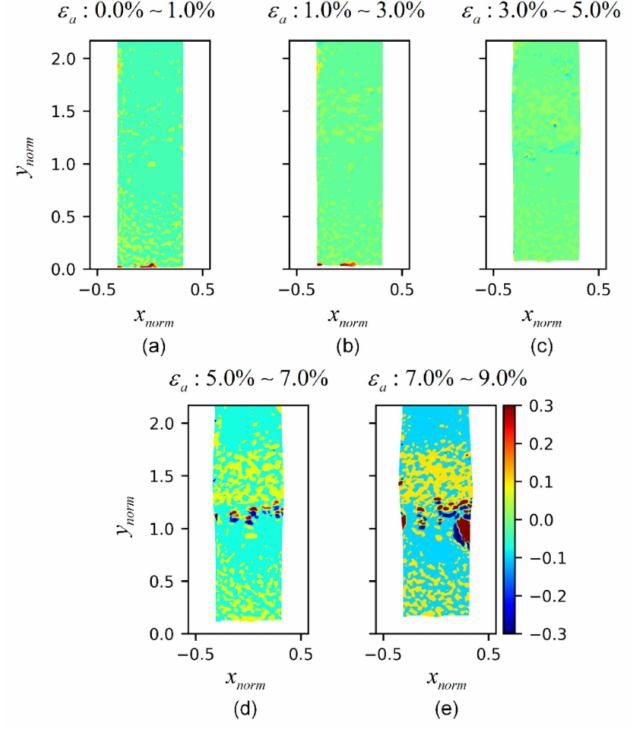
Figure 26. Evolution of divergence field div U of test 120704c: ( a ) axial strain 0.0%–1.0%; ( b ) axial strain 1.0%–3.0%; ( c ) axial strain 3.0%–5.0%; ( d ) axial strain 5.0%–7.0%; ( e ) axial strain